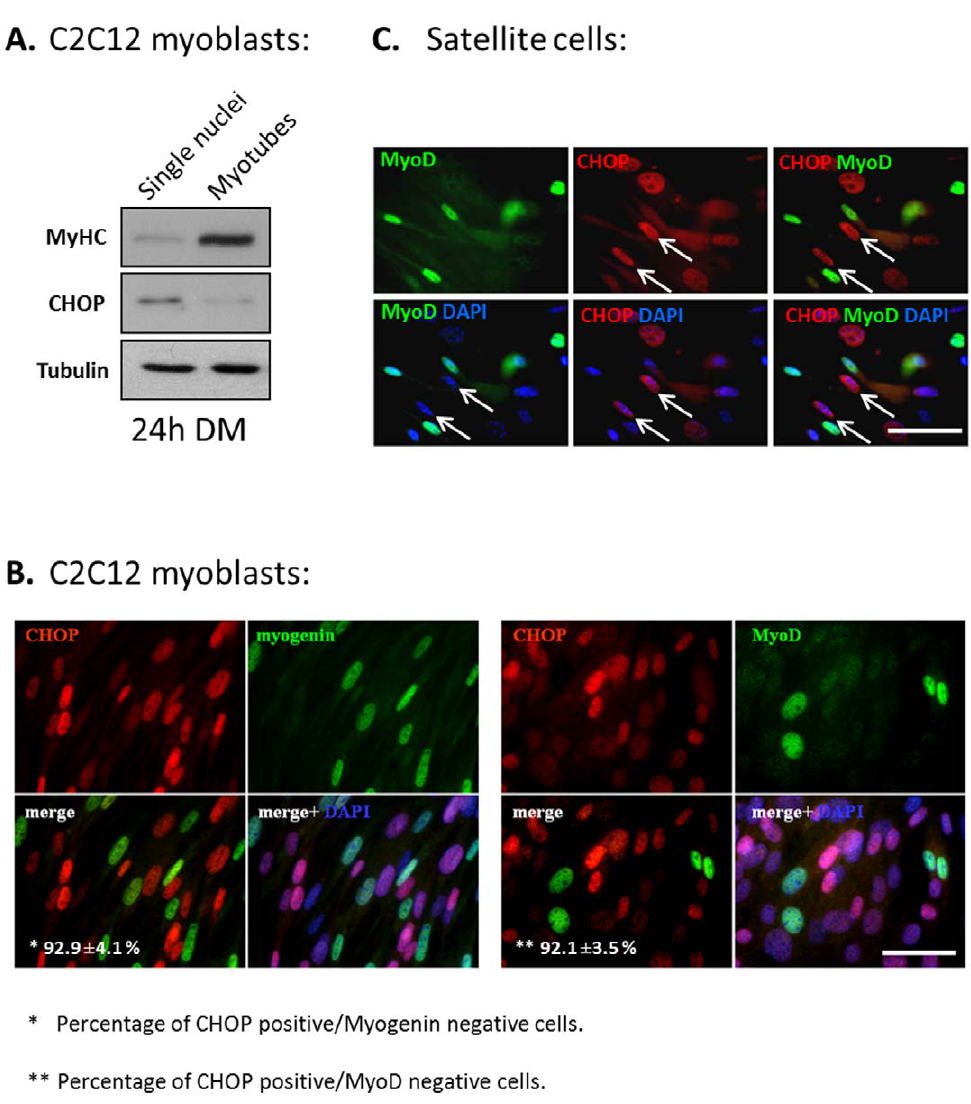
Figure 4. The expression of CHOP and MRFs is mutual exclusive. (A) C2C12 cells were grown in DM for 24 hours and mononucleated cells were separated from myotubes by selective trypsinization. The two cell populations were subjected to Western blot for analyzing the expression of CHOP. (B) C2C12 myoblasts were grown in DM for 24 hours, and double stained with antibodies directed against CHOP and myogenin (left panel) or with antibodies directed against CHOP and MyoD (right panel). DAPI in blue, MyoD and myogenin in green and CHOP in red. Percentage of CHOP positive, myogenin negative and CHOP positive, MyoD negative relative to the total number of CHOP positive cells was calculated in three independent experiments. Mean values and standard errors are presented. Bar, 50 m m. (C) The expression of CHOP in primary satellite cells. To induce their differentiation, satellite cells were grown for 24 hours in GM medium. Cells were analyzed by immunostaining with anti-MyoD (green) and anti- CHOP (red) antibodies. DAPI staining is in blue. Arrows point at nuclei positive for CHOP staining and negative for MyoD staining. Bar, 50 m